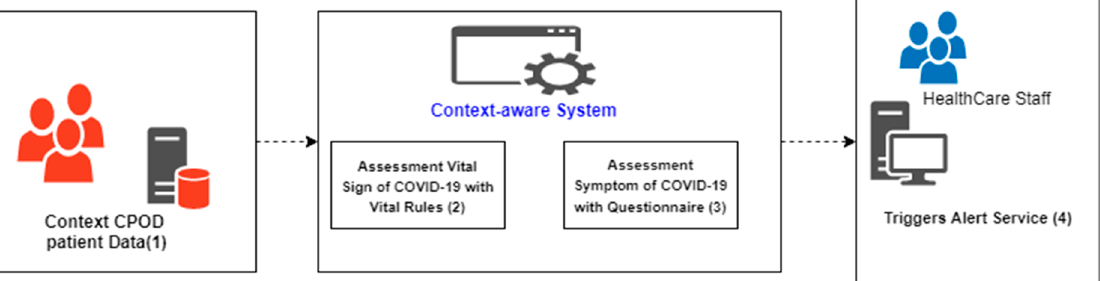
Figure 5. Reasoning process.